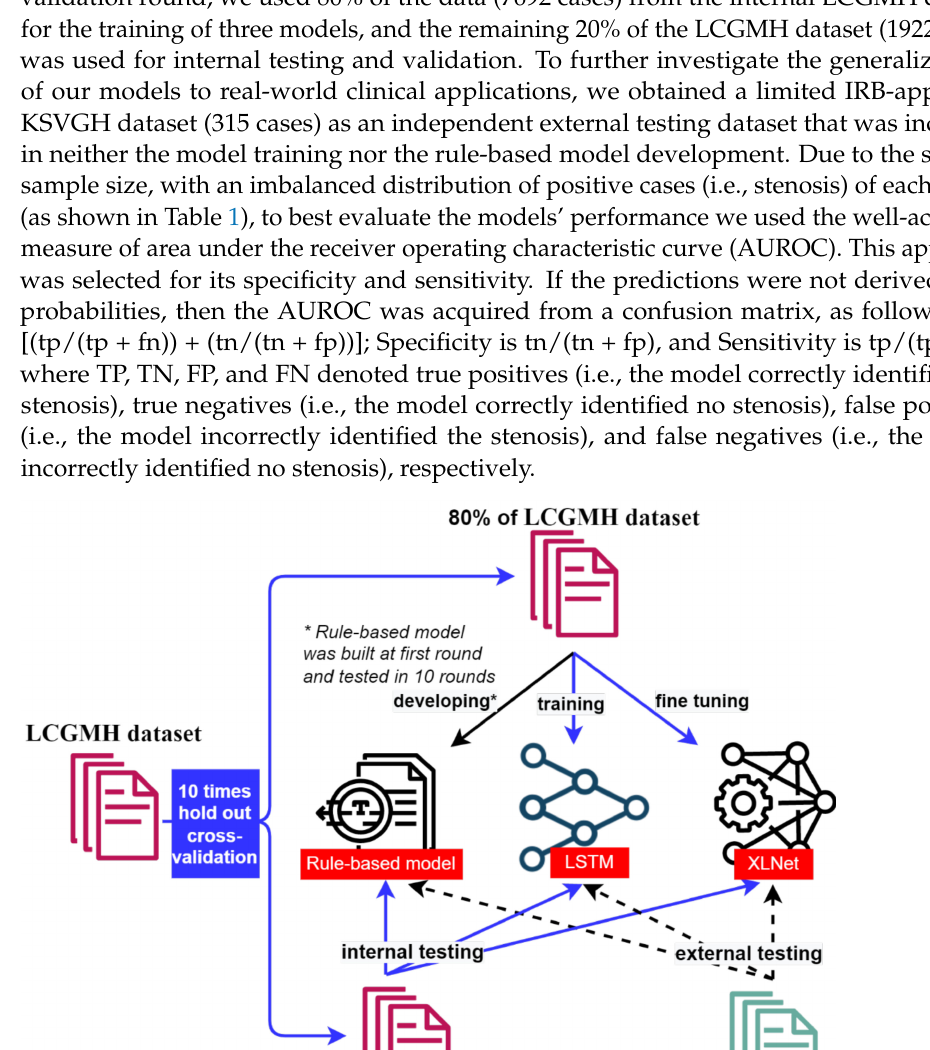
Figure 1 panel C, the token embedding layer transformed the texts to token identifiers and fed them into an XLNet pretrained model. This contained a linear layer corresponding to the number of target arteries employed in this study, with a sigmoid activation function added on top of the contexture embedding layer. For fine-tuning the model, we selected AdamW optimizer [29] with 1 × 10 − 5 learning rate and the sigmoid cross entropy with logits as the loss function. The final model was then trained for 20 epochs with 16 batch sizes.